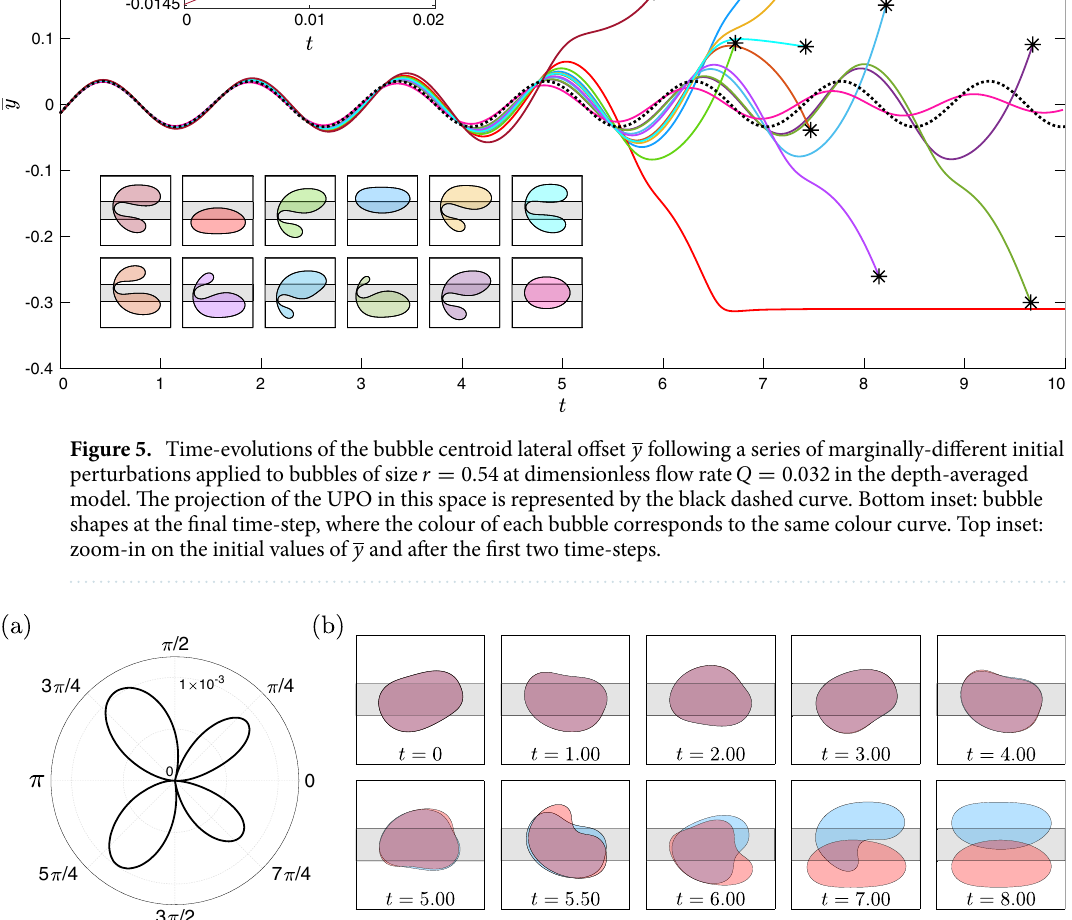
Figure 6. ( a ) Dimensionless radial difference between the initial bubble shapes at angular position θ , as measured from the axial centreline of the channel, for the two bubbles which evolve towards steady asymmetric propagation on either side of the rail in Fig. 5. ( b ) The corresponding time-sequences of their